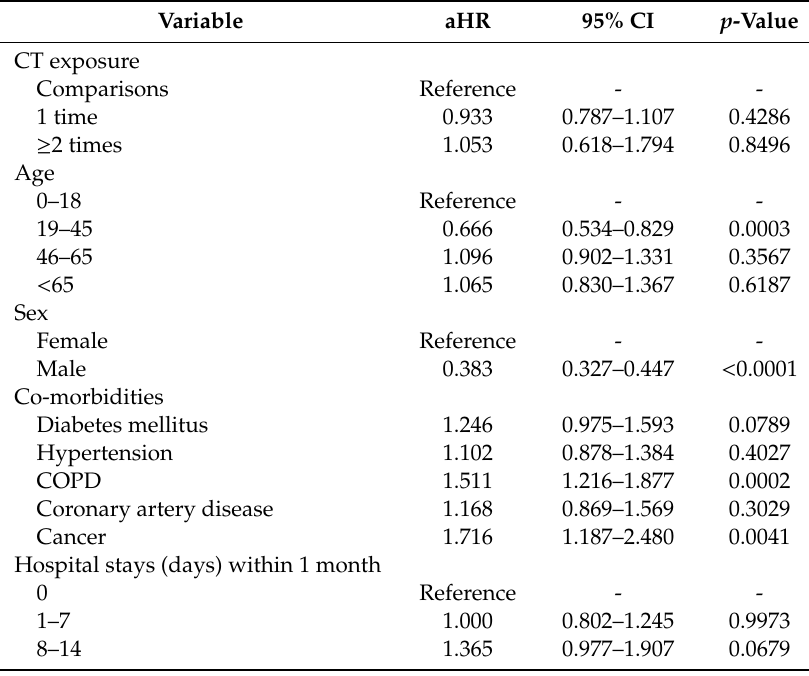
Table 3. Results of Cox proportional hazards analysis.